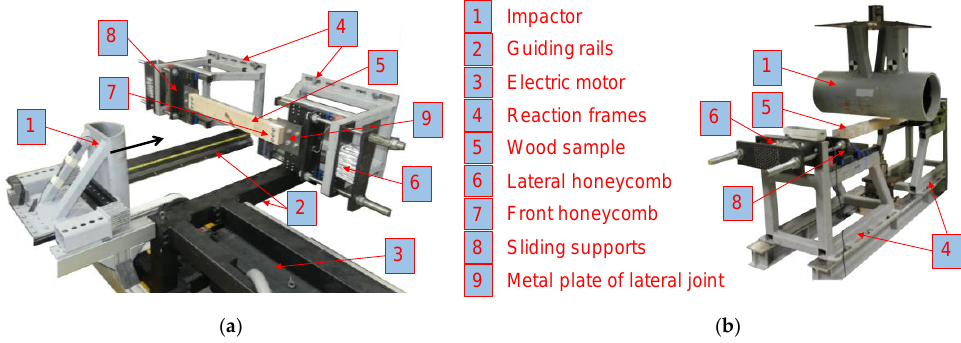
Figure 5. Test bench for the dynamic ( a ) and the quasi-static three-point bending test configuration ( b ).